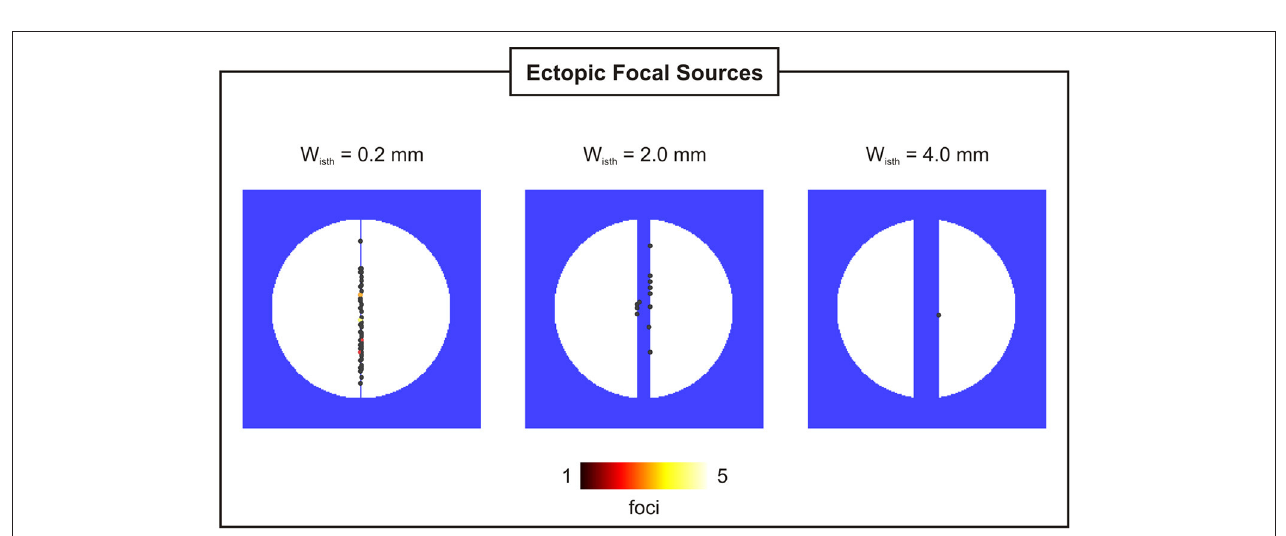
FIGURE 6 | Location and incidence of PVCs in 2D sheets with isthmus widths of 0.2, 2, and 4mm.